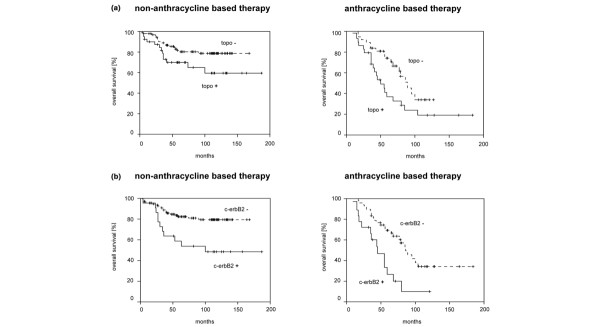
Survival of patients receiving either non-anthracycline-based therapy or anthracycline-based chemotherapy. (a) The difference between patients with less than 25% positive cells for topoisomerase IIα (dashed lines) and more than 25% positive cells (solid lines) was significant for both patient groups (P < 0.05). (b) Significant difference between patients with (solid line) or without (dashed line) c-erbB2 overexpression in the group of patients receiving non-anthracycline-based adjuvant therapy (left panel; P = 0.002) or an anthracycline-containing regimen (right panel; P = 0.001)